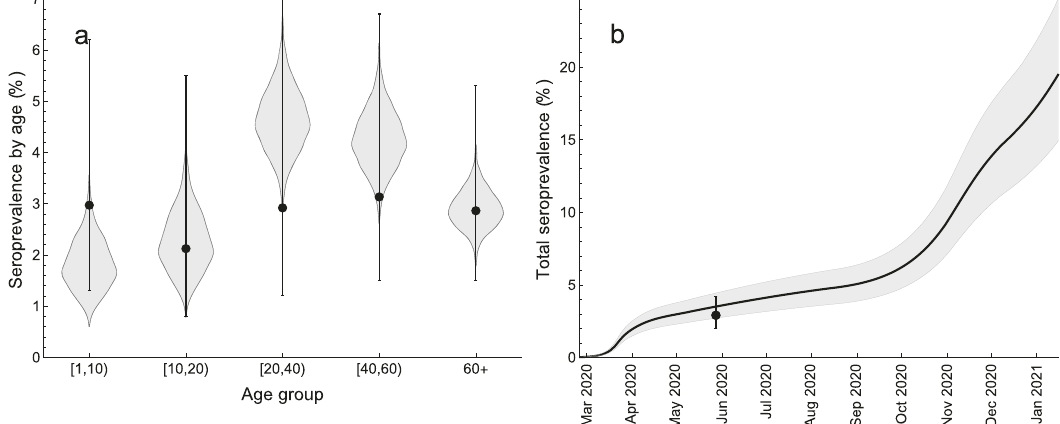
Fig. 2 Model fi t to SARS-CoV-2 seroprevalence. a Age-speci fi c seroprevalence. The violin shapes represent the marginal posterior distribution of the age- speci fi c seroprevalence in the model. b Total seroprevalence. The black line and the gray shaded region show the median total seroprevalence and 95% credible intervals. The uncertainty in the model is based on 2000 parameter samples from the posterior distribution. The data (dots - percentage seroprevalence and error bars - 95% con fi dence intervals) in a and b are taken from the cross-sectional seroepidemiological survey (First